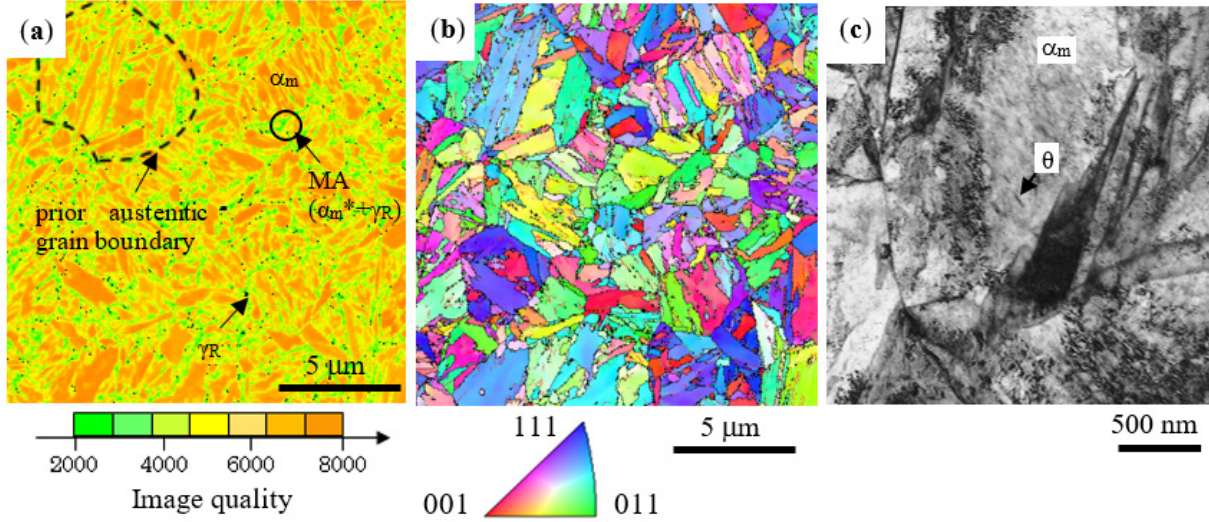
Figure 3. ( a ) Image quality distribution map and ( b ) inverse pole figure map of Fe- α (body centered cubic structure) phase and ( c ) TEM image in 0.21%C–1.49%Si–1.50%Mn–1.0%Cr–0.05%Mn TM steel subjected to the IT process at T p = 200 °C (< M f ) for 1000 s [62]. α m : coarse lath-martensite, α m *: fine lath/twin-martensite, γ R : retained austenite (black dots), MA: mar- tensite/austenite phase, θ : carbide in coarse lath-martensite. Reprinted with permission from ISIJ: ISIJ Int, Copyright 2021.